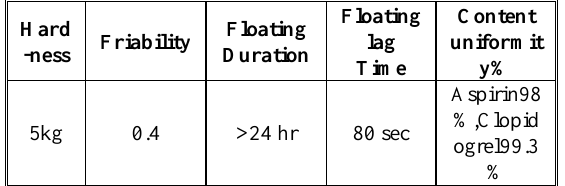
Table 5: Evaluation parameters of bilayer